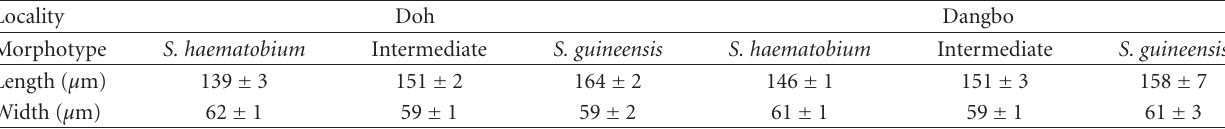
Table 1: Egg morphometry.